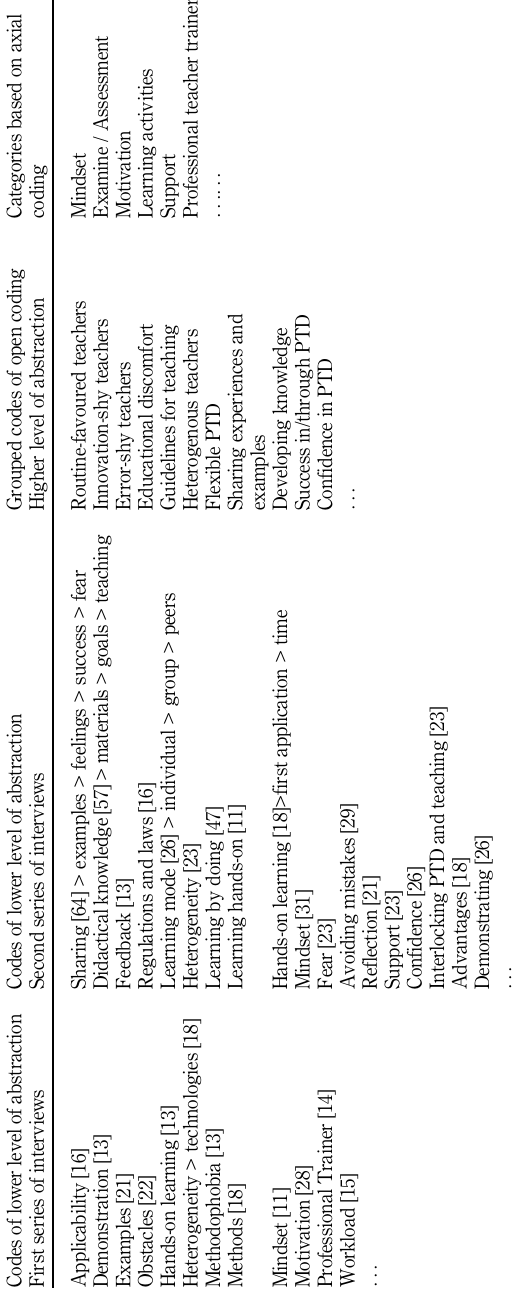
different levels of